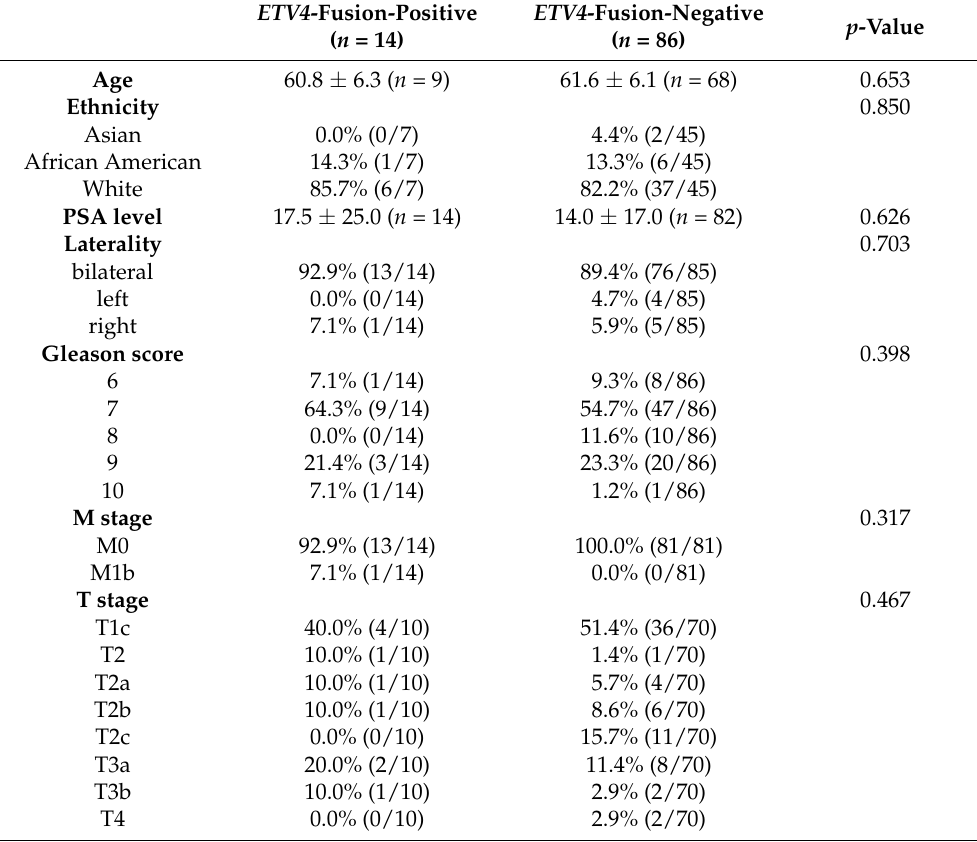
Table 1. Comparison of patient clinical characteristics of prostate cancer